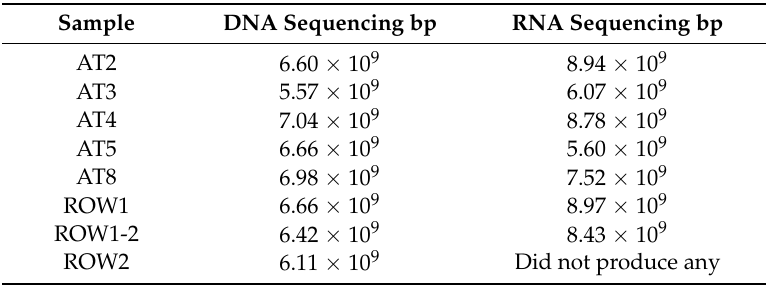
Table 2. Sequencing results for all samples in amount of base pairs